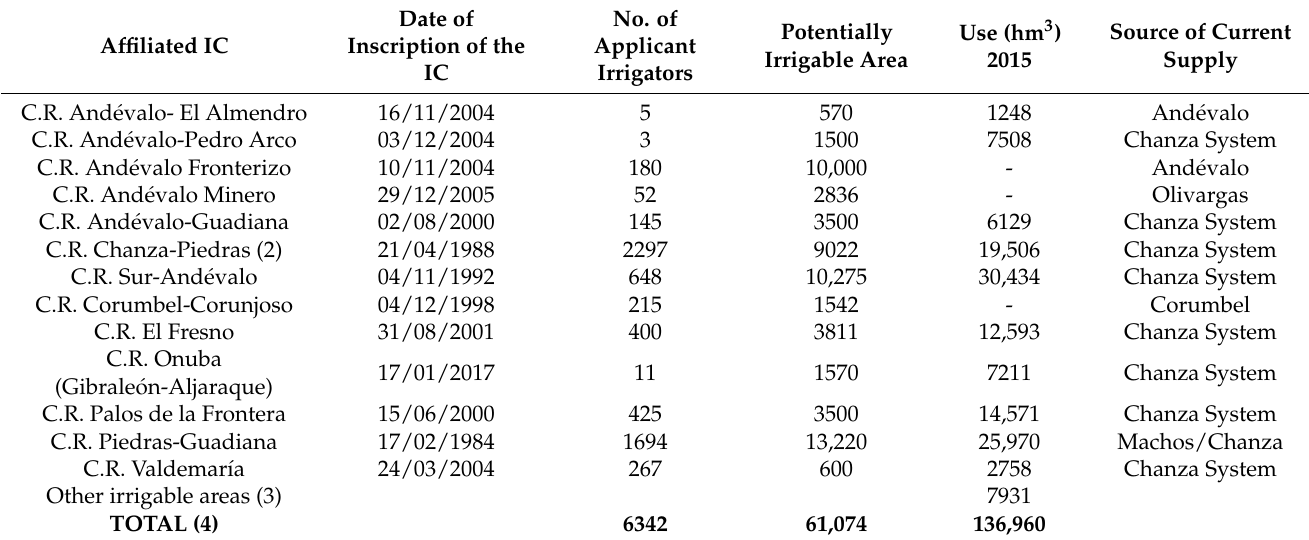
Table 6. Irrigation Communities in the River Basin District of Huelva